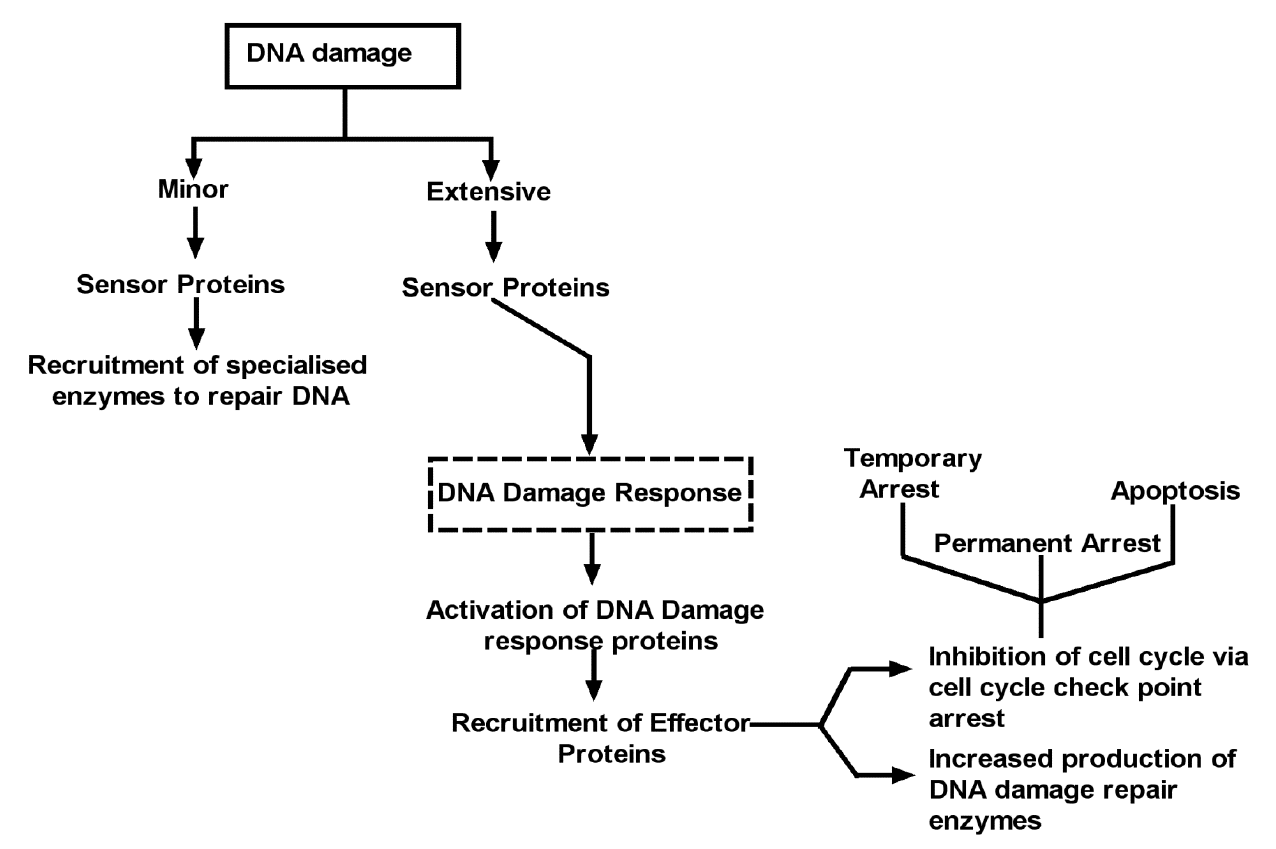
Figure 1: Cellular responses to DNA damage . Depending upon the scale of DNA damage, one of the two pathways is activated. If the DNA damage is minor, sensor proteins are activated which recruit specialized DNA repair enzymes to the damaged site and DNA is repaired. However, if the DNA damage is extensive, the DNA Damage Response (DDR) pathway is activated which activates specialized transducer proteins that amplify the damaged signal and activate effector proteins. The effector proteins cause cell cycle arrest and increase in the production of DNA damage repair enzymes. The arrest at the cell cycle checkpoints may result in temporary halting of the cell cycle, a permanent arrest or induction of apoptotic